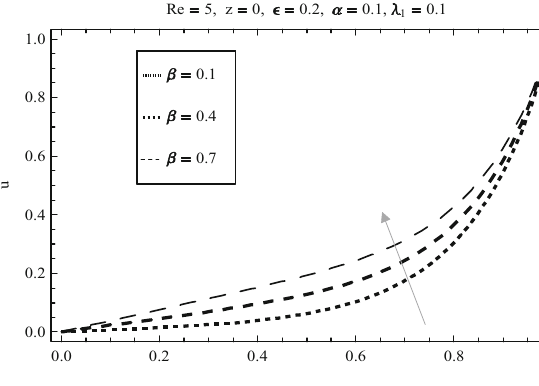
Fig. 3 Velocity component u along y for different values of β